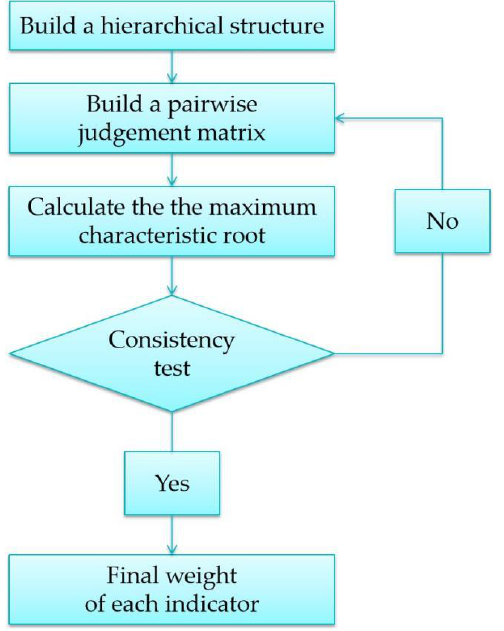
Figure 3. The basic steps of the AHP method. Table 2. Mean random consistency index